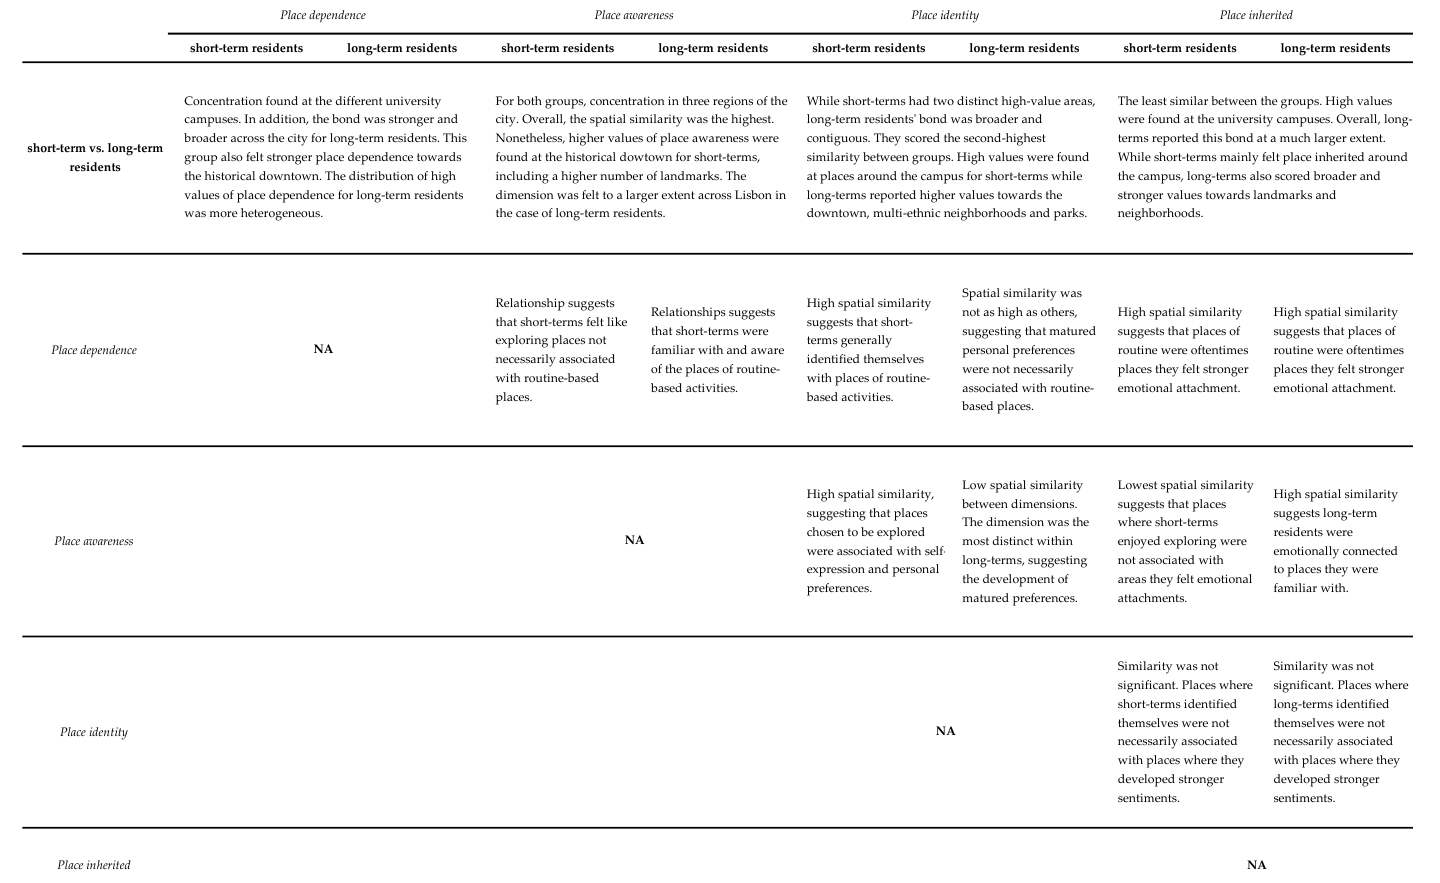
Table 7: Interpretation of the similarities and differences found between participant groups and between dimensions of sense of